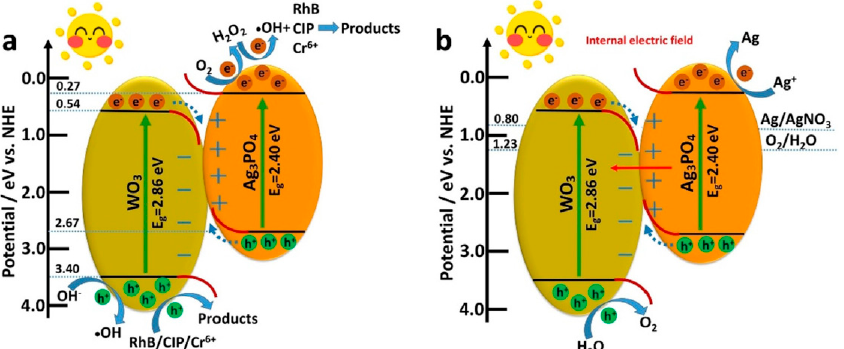
Figure 3. Schematic illustration of Ag 3 PO 4 /WO 3 S-scheme mechanism for photocatalytic degrada- tion and O 2 evolution [25]. ( a ) oxidizing RhB/CIP/Cr 6+ to CO 2 and H 2 O, ( b ) water splitting to generate O 2